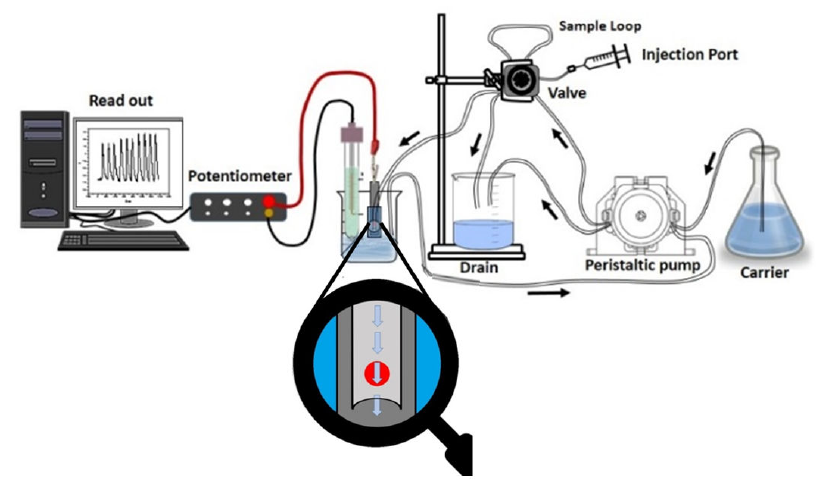
Figure 9. Flow injection setup used for determining Cr(VI) using paper and ceramic based sensors with PANI solid